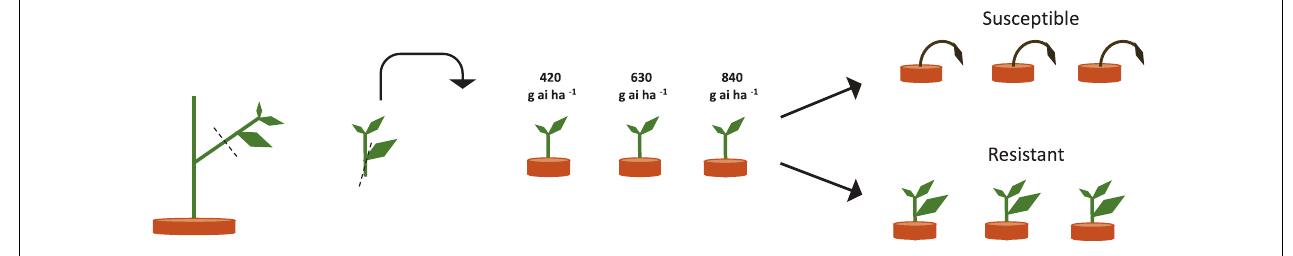
FIGURE 1 | Scheme of clone propagation method for parental plant herbicide phenotyping. Three clonal leaf cuttings were removed from individual parental plants and transplanted into pots to encourage rooting and re-growth. 18 days after propagation, three established clones per plant were treated with 420, 640, or 840 g ai ha − 1 of glyphosate. Survival and growth were assessed, and plants were scored as resistant or susceptible depending on plant survival, mortality and glyphosate symptoms at the three glyphosate